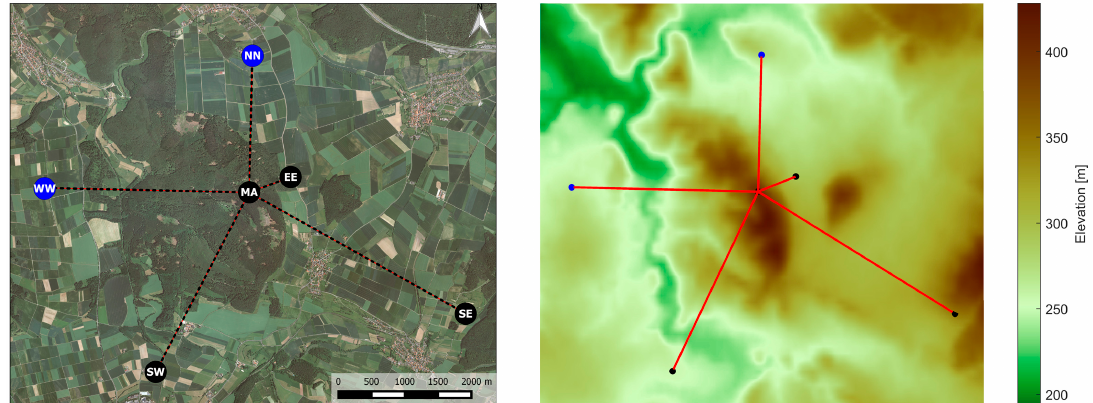
Figure 2. Instrumental setup during the measurement campaign. Left: aerial photograph (data source: published with kind permission of ©Hessische Verwaltung für Bodenmanagement und Geoinformation (HVBG)) with circles indicating the locations of the lidar and the met mast; the locations which are used in this study are indicated in black. Right: terrain (data source: Shuttle Radar Topography Mission [31] version 2.1) and trajectories of the intersecting lidar beams for the ML measurement. The windcube v2 (WC) is also located at the MA position.